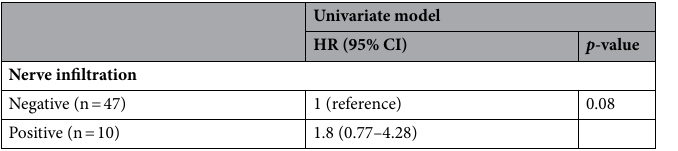
Table 2. Univariate Cox proportional hazards regression models of the association between nerve infiltration and survival. HR was calculated using univariate Mantel–Haenszel hazard model. HR hazard ratio, CI confidence interval. P -values were calculated by the log-rank